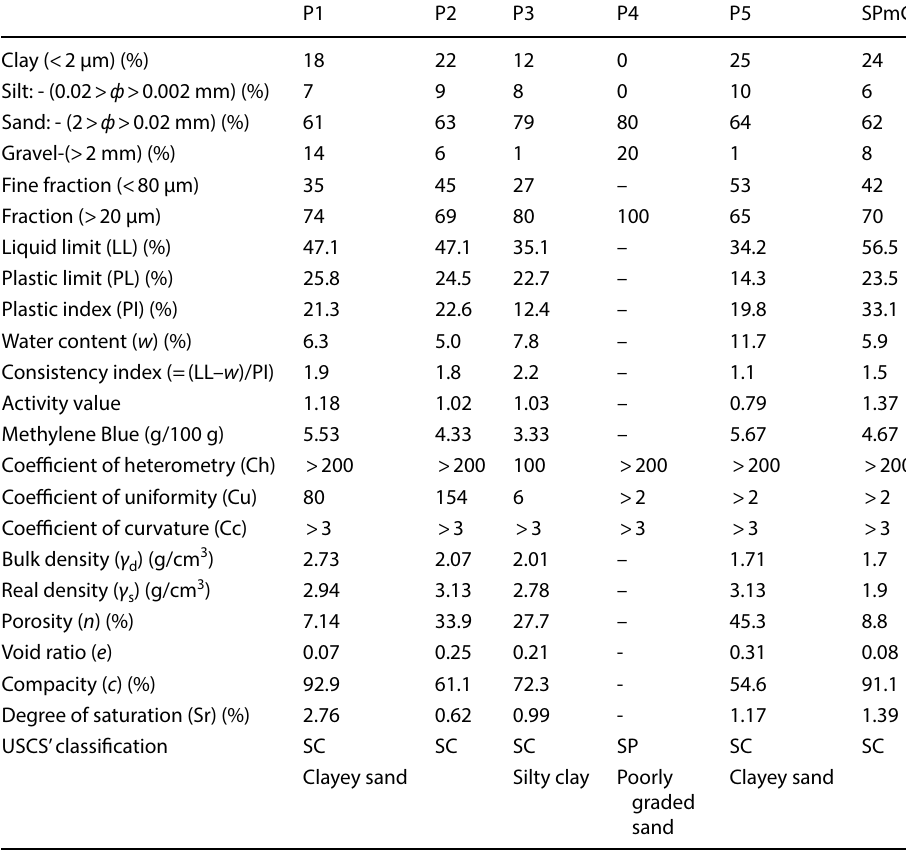
Table 3 Geotechnical properties of Boulgou clayey